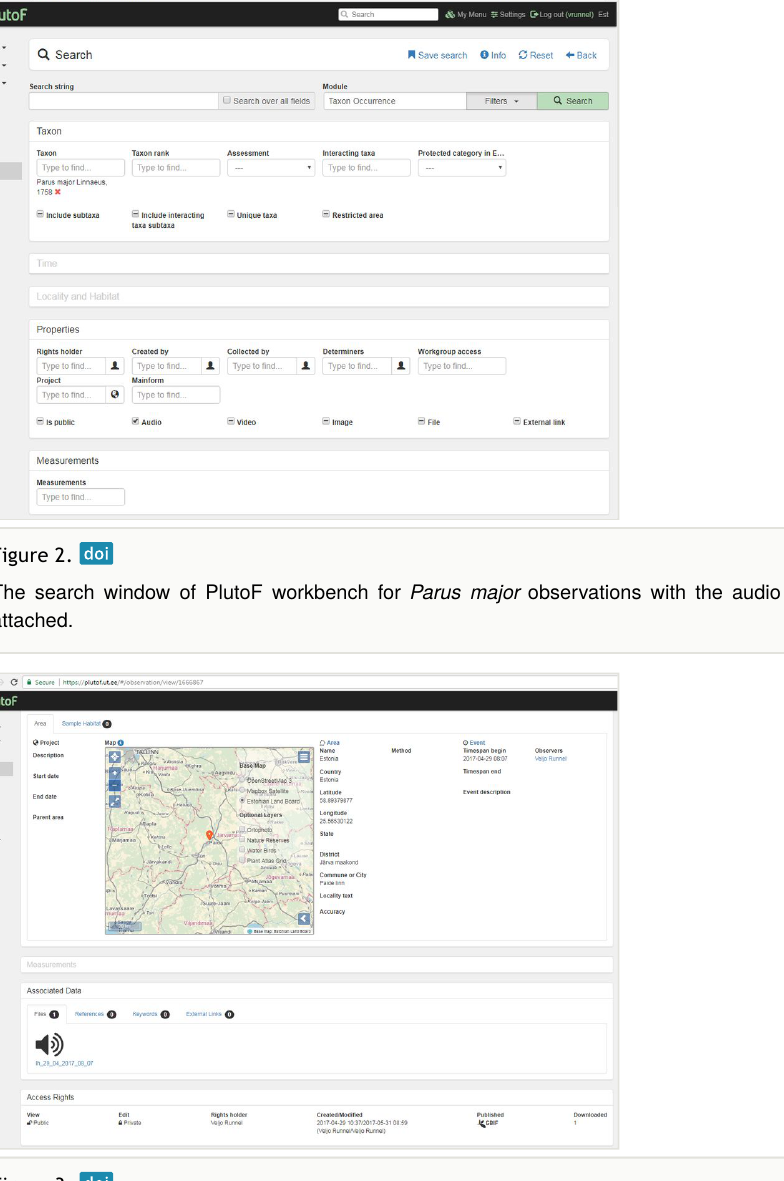
The menu item of the PlutoF workbench which shows how the audio fi le is linked to an observation